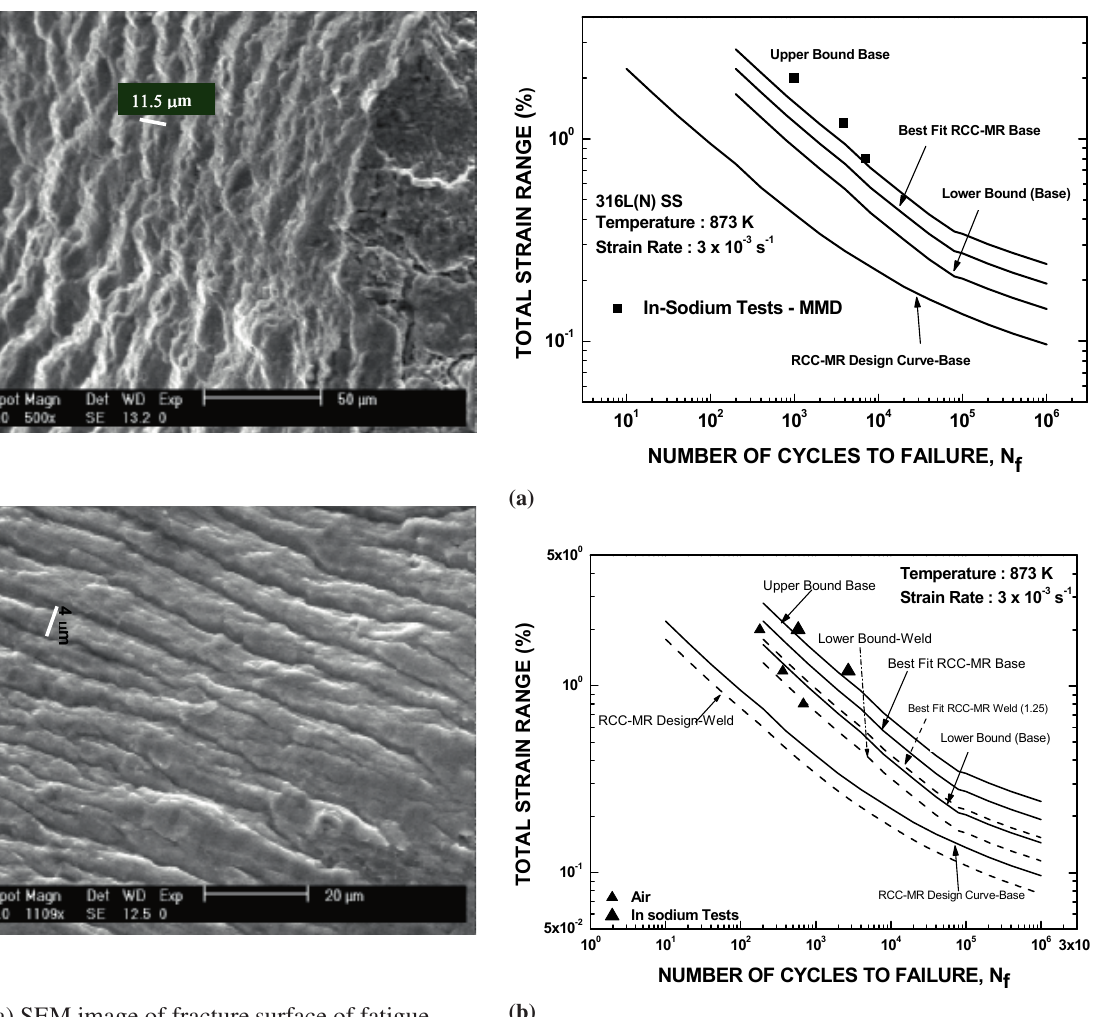
Figure 7. (a) SEM image of fracture surface of fatigue tested 316L(N) base material in air (873 K), (Please clearly present the scale in the figure. Larger font size is better for 11.5 µm); (b) SEM image of fracture surface of 316L(N) base material tested in sodium (873 K) .